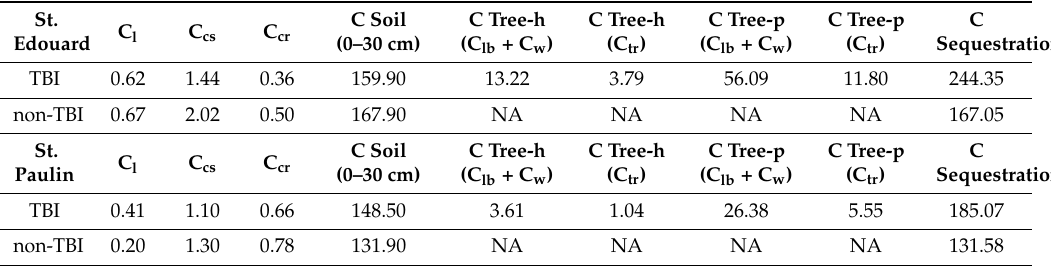
Table 1. Carbon contained in crop, tree and soil components, and C sequestration in tree-based intercropping (TBI) and adjacent agricultural systems (non-TBI), expressed as the t C ha ´ 1 in each component (in the rows labeled TBI and non-TBI). Values were estimated from measurements taken in 10-year old TBI and non-TBI systems at St. Edouard and St. Paulin experimental sites in Quebec, QC,